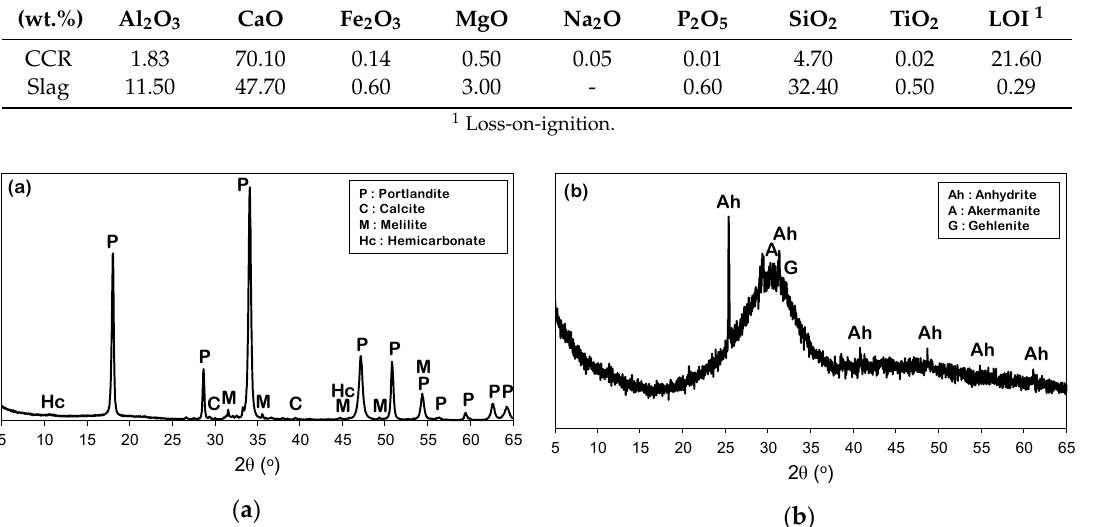
Table 1. Chemical compositions of the CCR and slag used in this study.